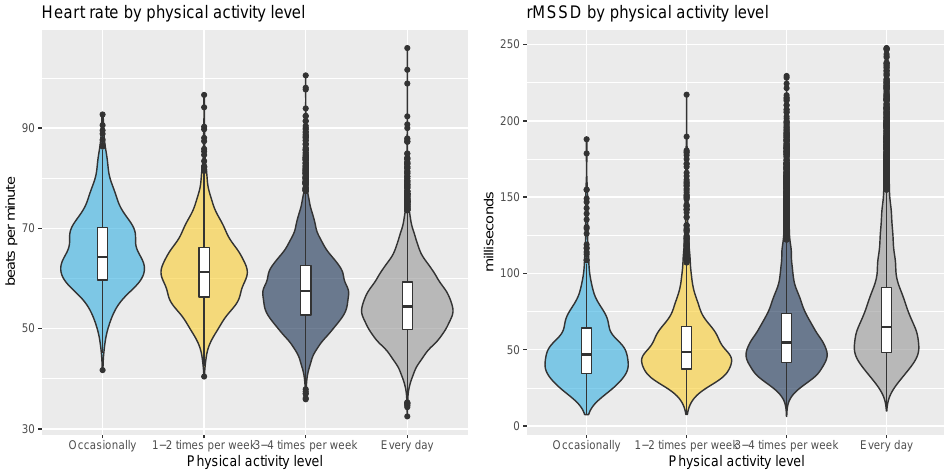
Figure 7. Relationship between heart rate, HRV, and physical activity level. While both resting heart rate and HRV show more positive physiological profiles for the most active individuals, the relationship is stronger for resting heart